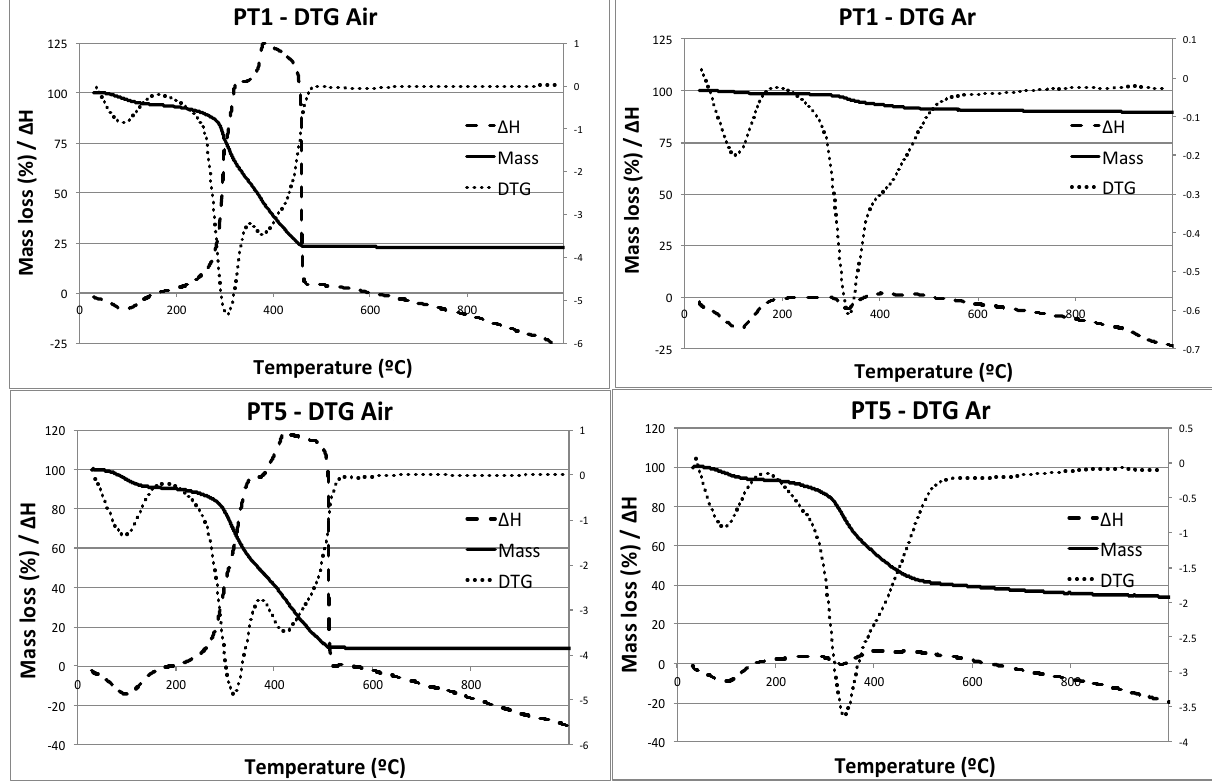
Figure 1. Thermal gravimetric and differential thermal analysis (TG/DTA) profiles of PT1 and PT5 under air (left plot) and argon (right